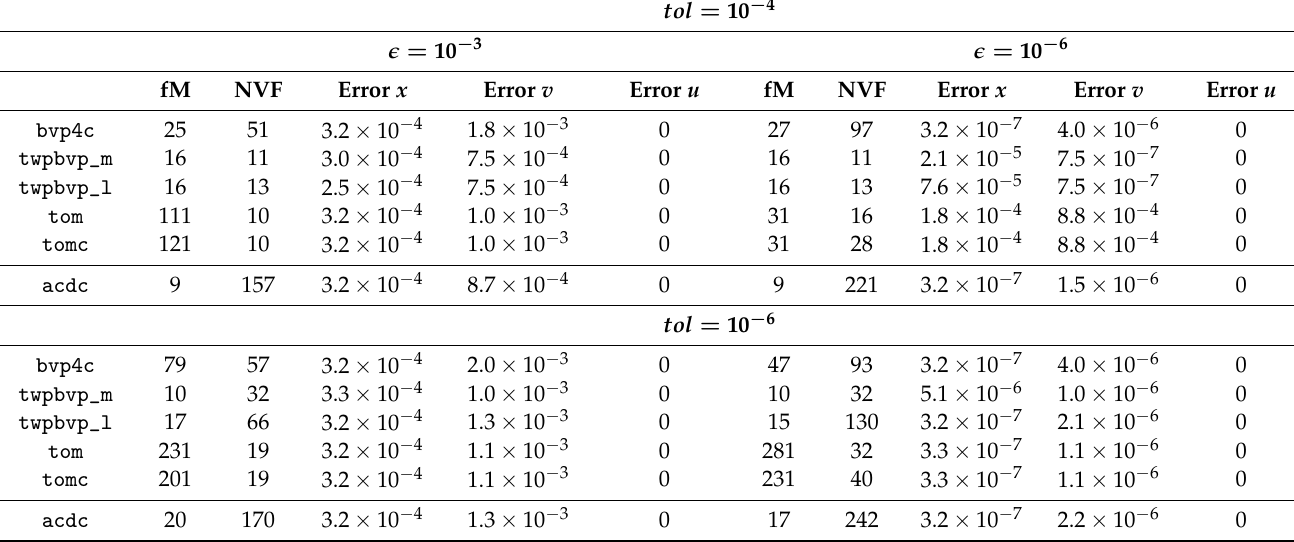
Table 11. Bang-Bang optimal control Problem (9): final mesh (fM), total number of vectorized function evaluation (NVF) and mixed errors for x , v , u